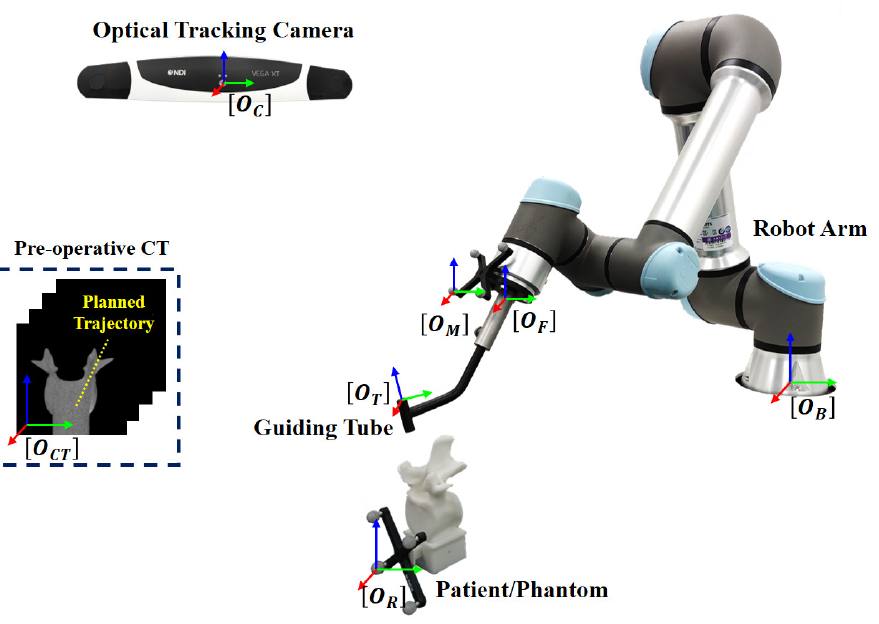
Figure 1. The involved coordinate systems for robot-assisted, image-guided pedicle screw insertion. During a pedicle screw insertion procedure, the pose of the guide is adjusted to align with a trajectory, which is planned in a pre-operative CT first, and then is transformed to the patient space via a surface